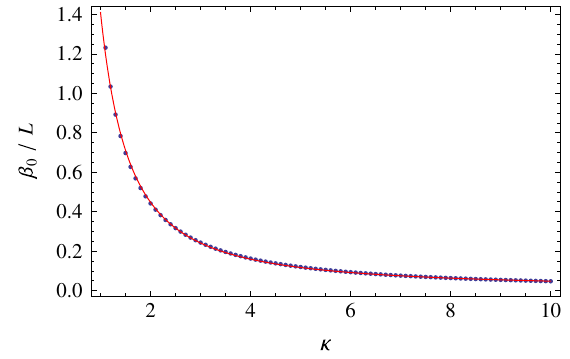
FIG. 7. Maximum improvement factor for AME emittance as a =B . The blue dots are the exact values. function of (cid:12) ¼ B max ref The red curve is given by the approximate expression 1 = ^ F ð (cid:12) Þ ¼ (cid:1) 0 : 504 þ 2 : 08 (cid:12) (cid:1) 0 : 389 (cid:12) 2 þ 0 : 0383 (cid:12) 3 (cid:1) 0 : 001 43 (cid:12) 4 . The val- ues at (cid:12) ¼ 2 , 4, and 6 agree with the results in [12].